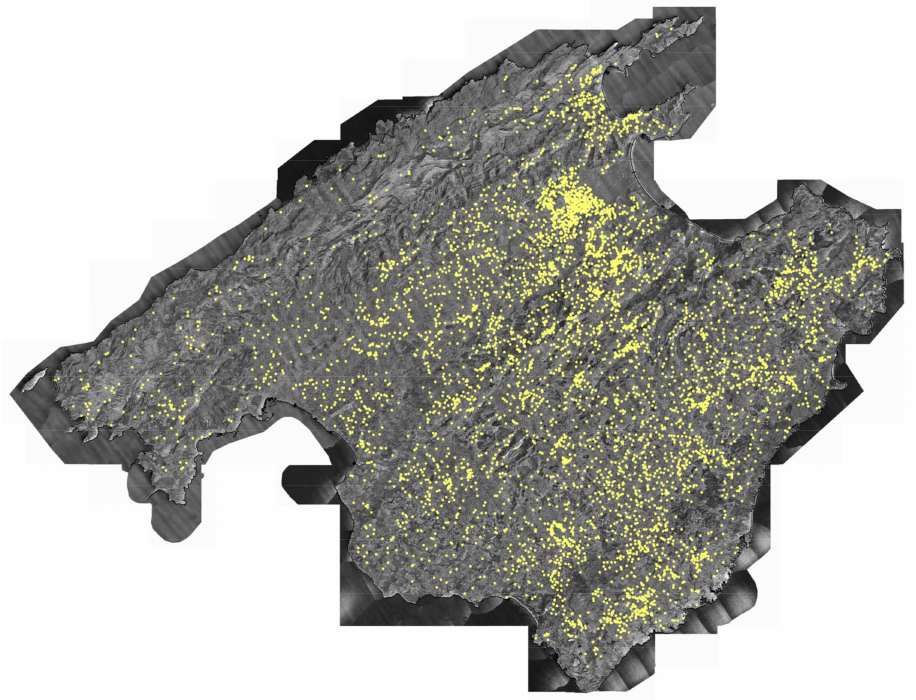
Figure 10. Spatial distribution of threshing floors (yellow dots, n = 5890) around de island of Mallorca, for the year 1956, on an aerial photographs mosaic of this